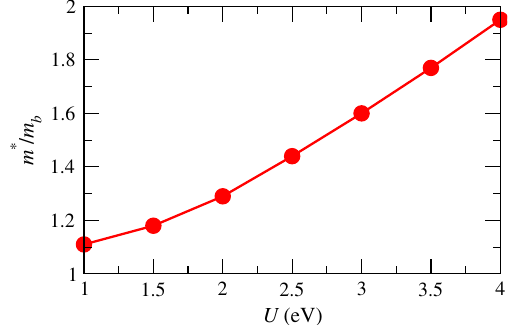
FIG. 2. Ratio between the effective electronic mass m (cid:2) , in the presence of on-site Coulomb interaction U , and the mass m obtained from a LDA